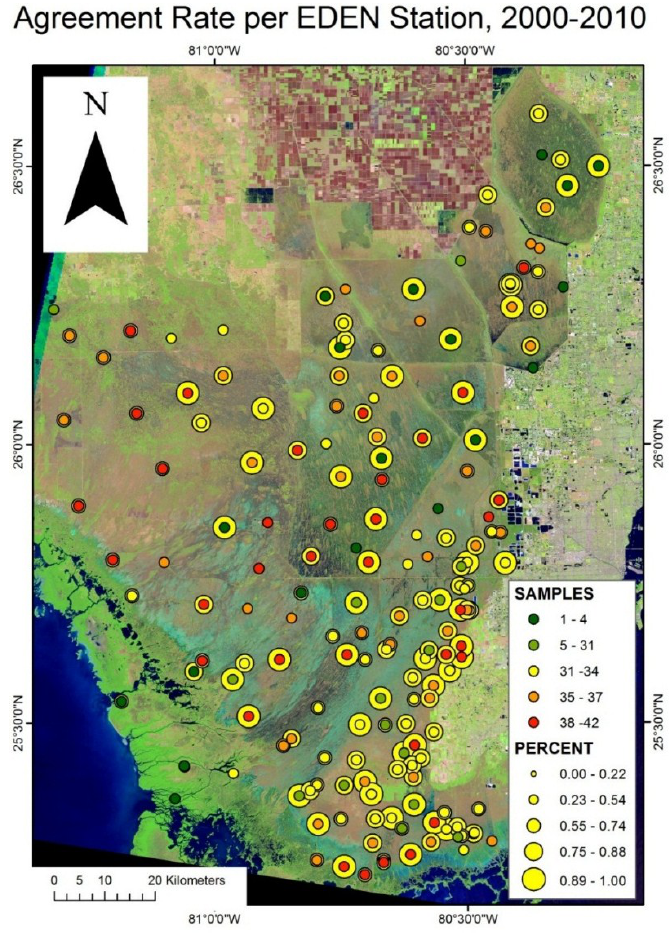
Figure 15. A multivariate map showing the locations of individual EDEN gages, the number of observations at each gage displayed on top of agreement rates for each gage given the 50 scene database spanning 11 years and a false color composite Landsat image backdrop (Band 5: Red; Band 4: Green; and Band 3: